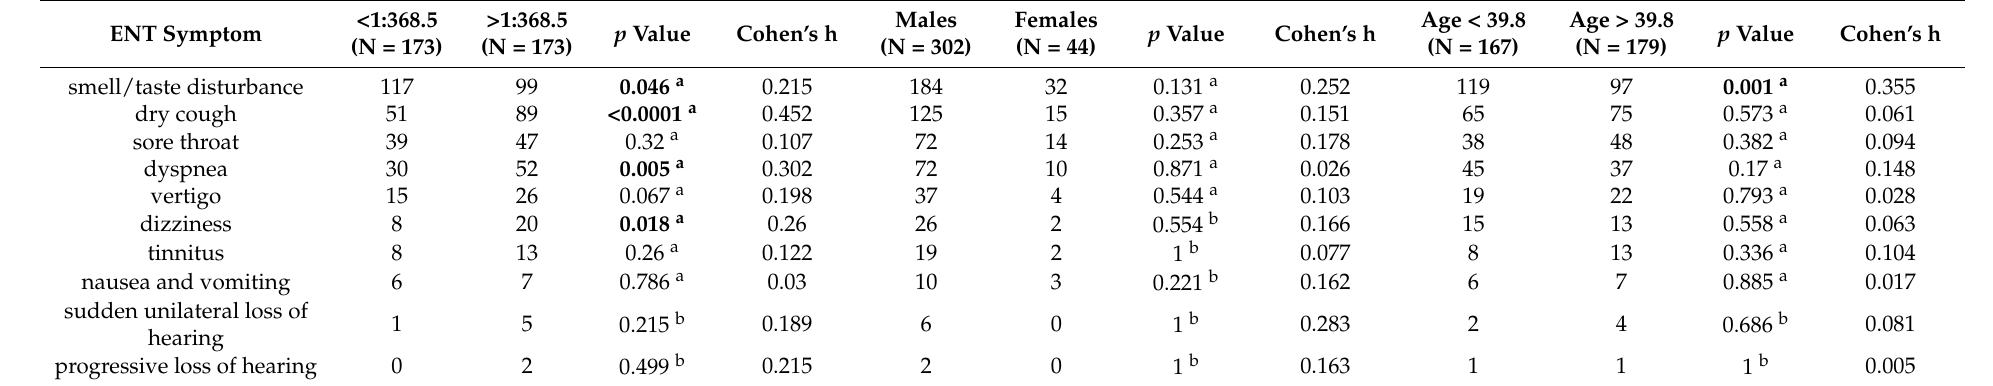
Table 2. Statistical analysis of ear, nose, and throat (ENT) ENT symptoms by antibody titer; sex, and (age. The chi-square test and the Fisher exact test were used to derive the p -values; p < 0.05—outcome statistically significant (marked in bold); Cohen’s h effect size was presented; 1:368.5—median antibody